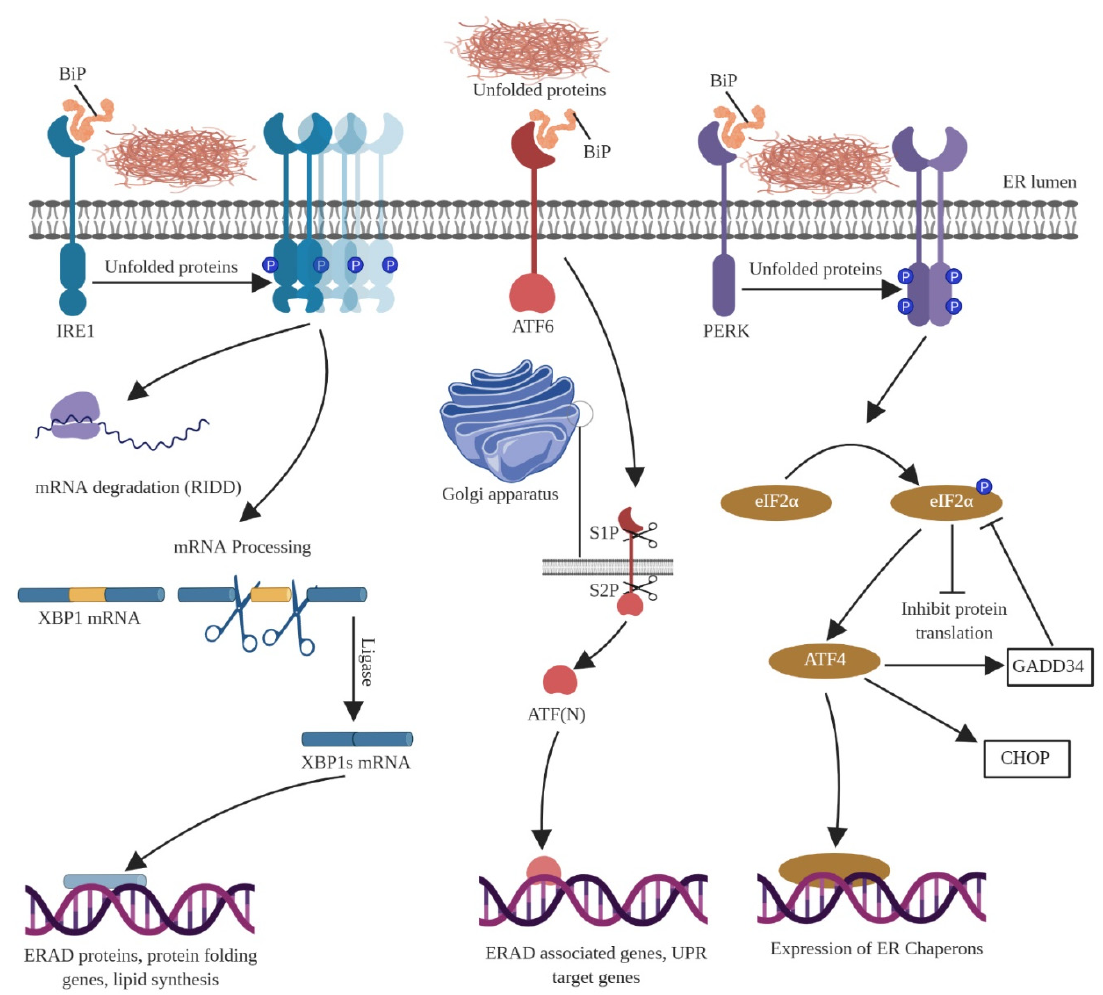
Figure 4. The molecular pathways of the unfolded protein response (UPR. During ER stress the three ER transducers (IRE1, PERK, and ATF6) tend to get activated and start the UPR mechanism to counteract the ER stress and to bring back the homeostasis. Failure to negate the ER stress will result in cell death. IRE1 undergoes oligomerization in response to unfolded proteins and the BiP gets dissociated from IRE1. IRE1 undergoes either mRNA degradation or mRNA processing with the help of XBP-1, which triggers the production of protein folding genes thereby mitigating ER stress. On the other hand, ATF6 gets into the secretory pathway inside the Golgi apparatus wherein the S1P and S2P cleave the ATF6. ATF6 fragments then translocate into the nucleus, which act as a transcription factor to generate UPR target genes. PERK first phosphorylates itself and also phosphorylates eIF2 α thereby inactivating eIF2B, which further inhibits the translation of serine 51. This process leads to the translation of ATF4 producing ER